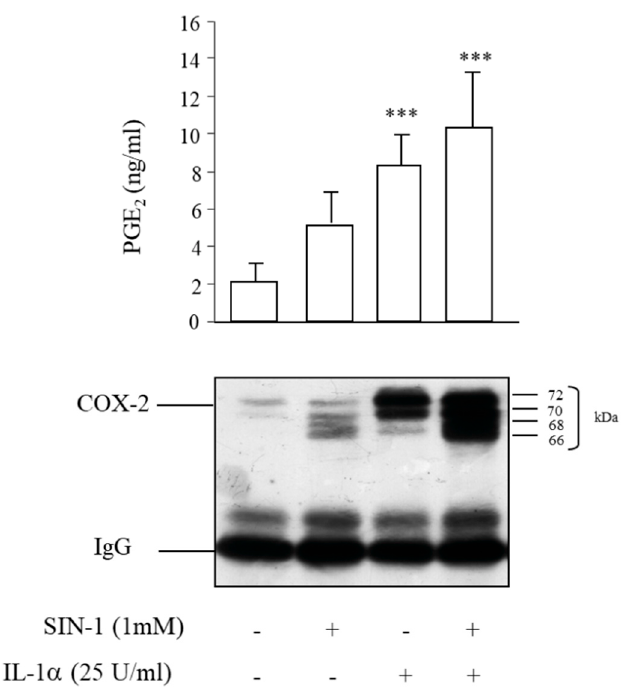
Figure 7. COX-2 activity is partially recovered after immunoprecipitation of the enzyme. HUVEC were treated with SIN-1 or IL-1 α either alone or in combination for 18 h and then COX-2 was immunoprecipitated. PGE 2 production was measured after the exposure of immunoprecipitates to 25 μ M arachidonic acid for 10 min and determined by EIA. n = 6 independent experiments; *** p < 0.001 vs. unstimulated cells.